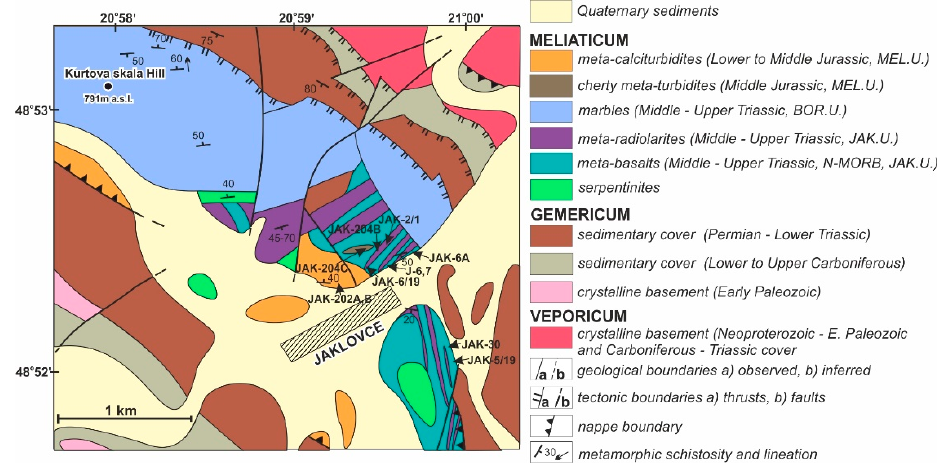
Figure 5. Schematic geological map of Meliaticum from the Jaklovce area (modified from [48,50]).